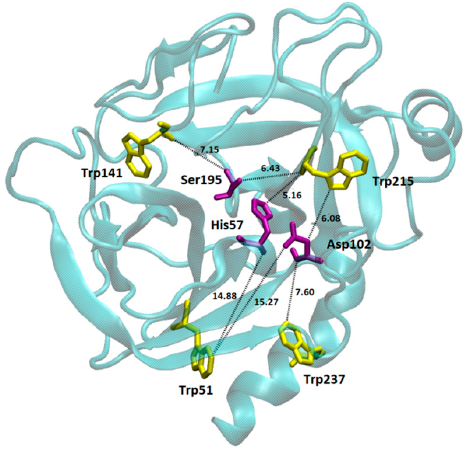
Figure 6. Spatial structure of trypsin (PDB ID: 1s0q) shown by ribbon representation with indicated position of catalytic triad Ser195-His57-Asp102 (violet sticks) and tryptophan residues (yellow sticks). Dotted lines connect the closest atoms of the triad and tryptophans; corresponding distances are indicated in Å.